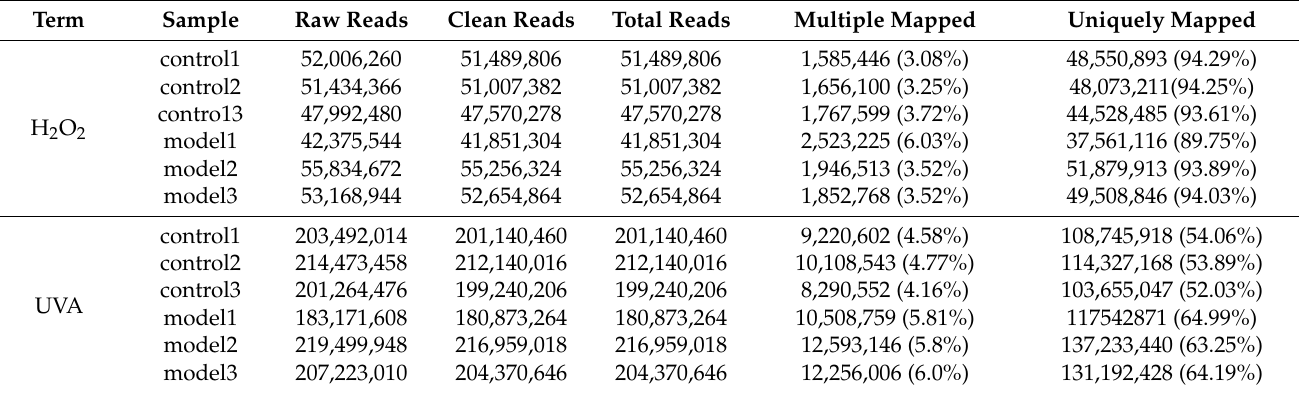
Table 1. Summary of read screening and mapping results of the sequences generated from cells with different